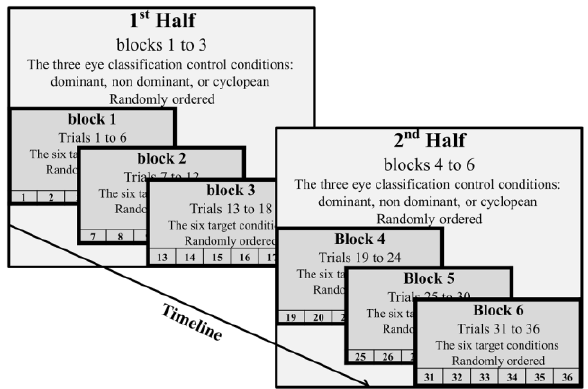
Figure 5: Experimental